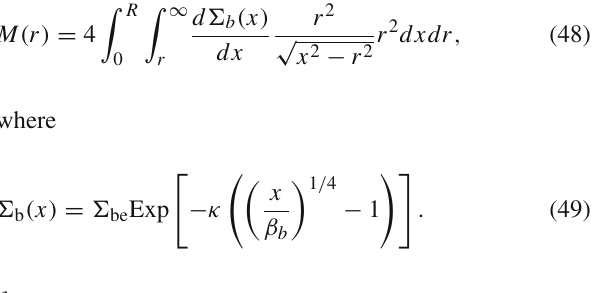
Table 3. The S values for n = 1 . 00001 and for n = 1 . 000001 are 2 . 78 × 10 9 and 1 . 43 × 10 29 respectively. This clearly indicates that n = 1 . 00001 provides us with the best f ( T ) rotation curve